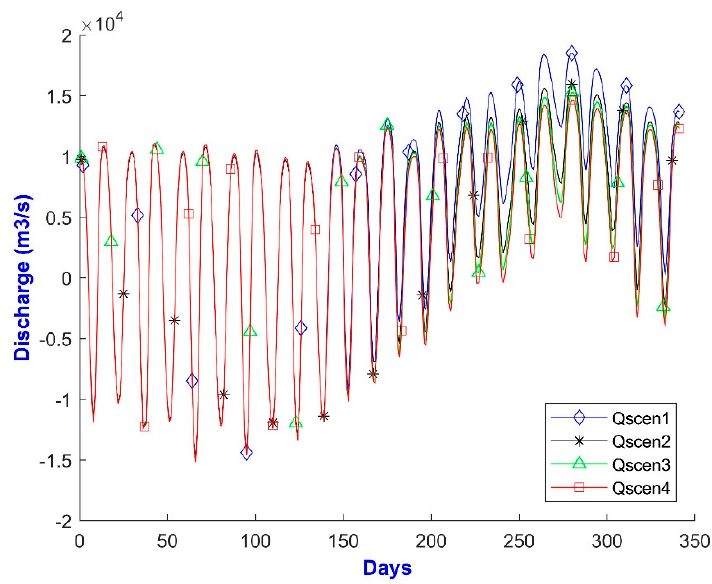
Figure 8. River discharges at Can Tho simulated from the MIKE 11 model for four scenarios.